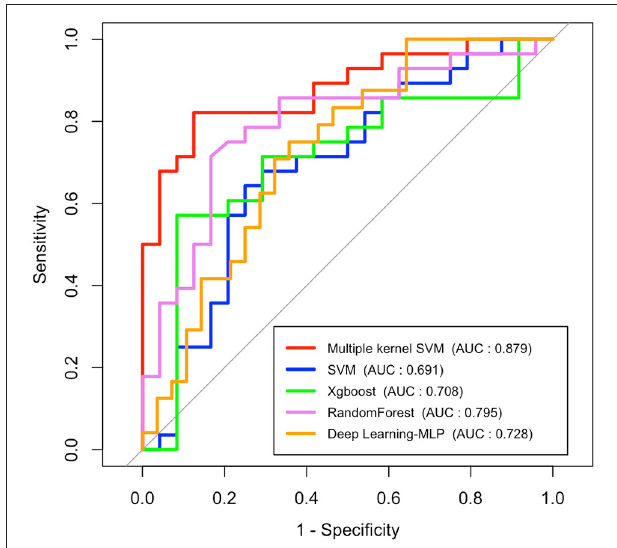
FIGURE 4 | ROC curves and AUC values of conventional machine learning methods, deep learning method (multilayer perceptron model), and multiple-kernel